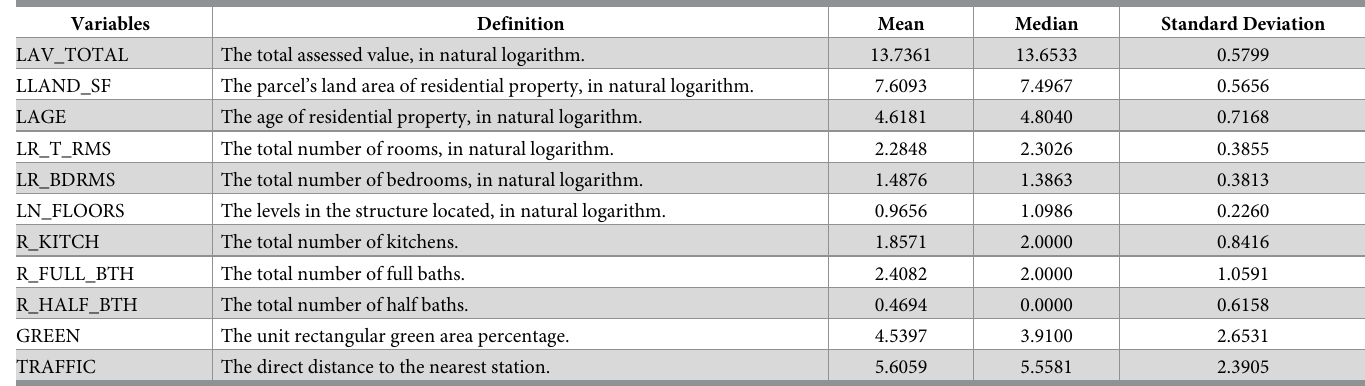
Table 1. Descriptive statistics of the data for Boston.